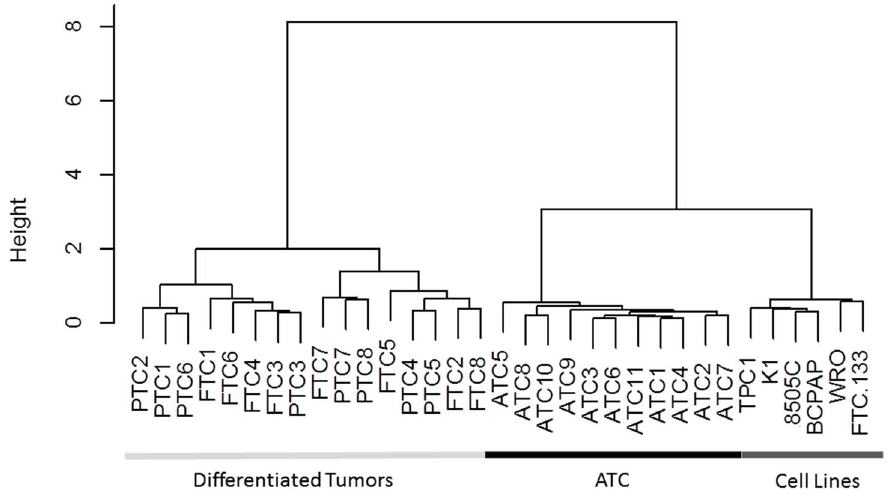
Figure 3. Hierarchical clustering of the microarray data from the 6 cell lines and from different malignant thyroid tumors (PTC, FTC and ATC). Hierarchical clustering was generated using R 2.14.1. The method used to compute the distance was ‘‘Ward’’. All the cell lines clustered together, with the ATC showing that the cell lines are closest to the dedifferentiated tumors than the tumors from which they derived. The data from the six cell lines were the mean of triplicate experiments. Differentiated tumors refer to papillary (PTC) and follicular (FTC) thyroid carcinomas.